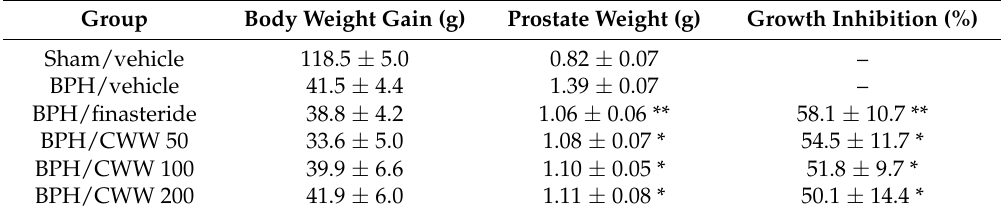
Table 1. Effects of aqueous Cynanchum wilfordii extract (CWW) on body weight gain, prostate weight, and growth